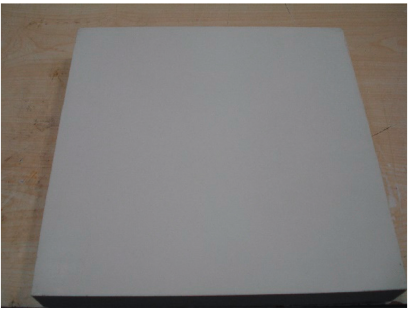
Figure 3: Polishing applied specimen. Table 3: Details of the parameters used for the ANNs and MR models developed.